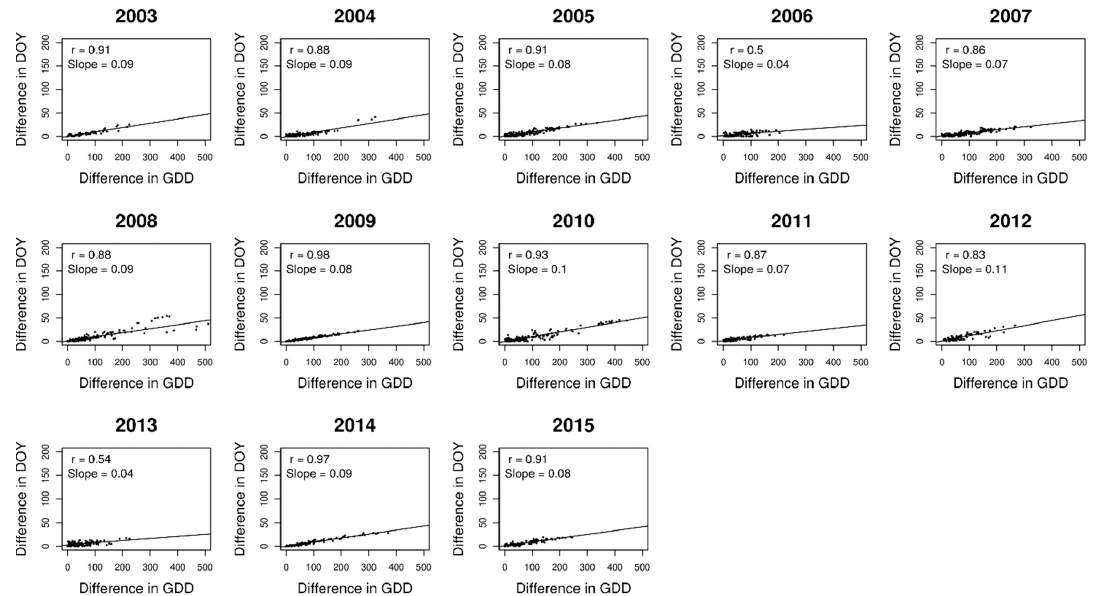
Figure A6. Linear regression fit between the difference in observed flowering DOY (number of days) and the difference in modelled GDD (number of degree days) for pairs of spatially connected observations of pedunculate oak leafing onset (see Figure A3). Correlation coefficient and rate of spatial change in DOY per unit of GDDs (i.e., slope of regression line) are given for each observation year.